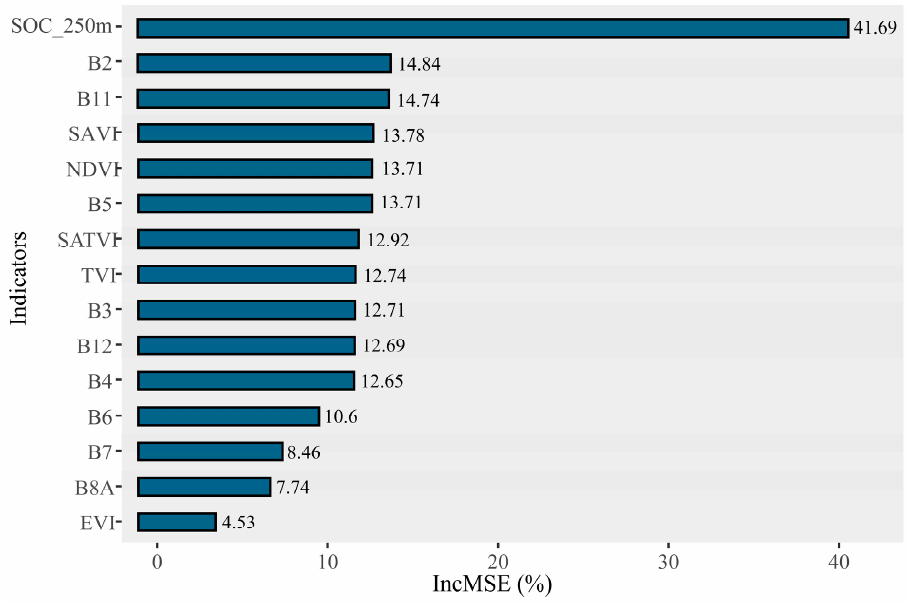
Figure 4. The variable importance projection values distribution in RF.